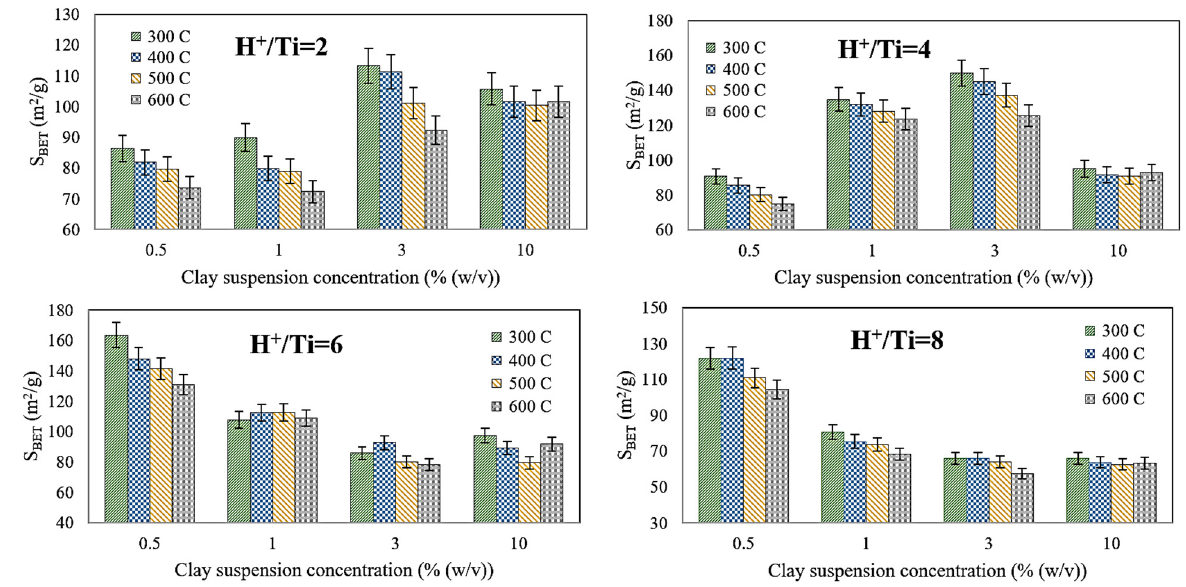
Figure 4. Effects of clay suspension concentration on the specific surface area of Ti-PILC at different ratios of H + /Ti and calcination temperatures.